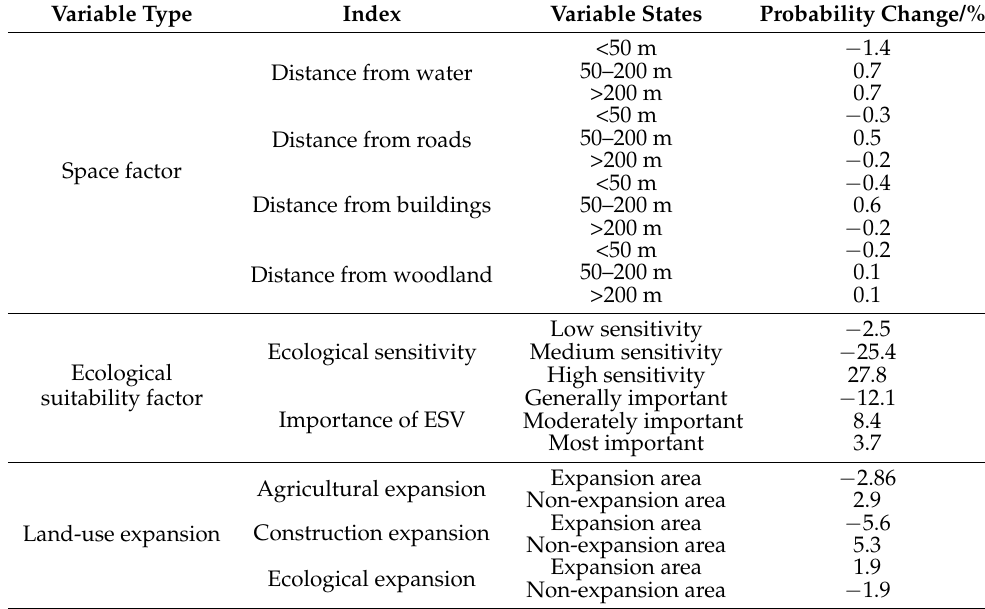
Table 4. Diagnostic analysis